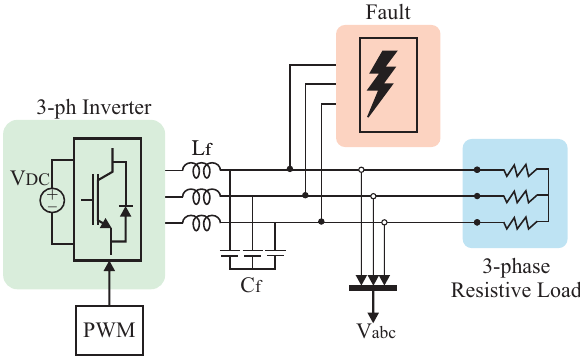
Figure 6. Case study schematic for a three-phase